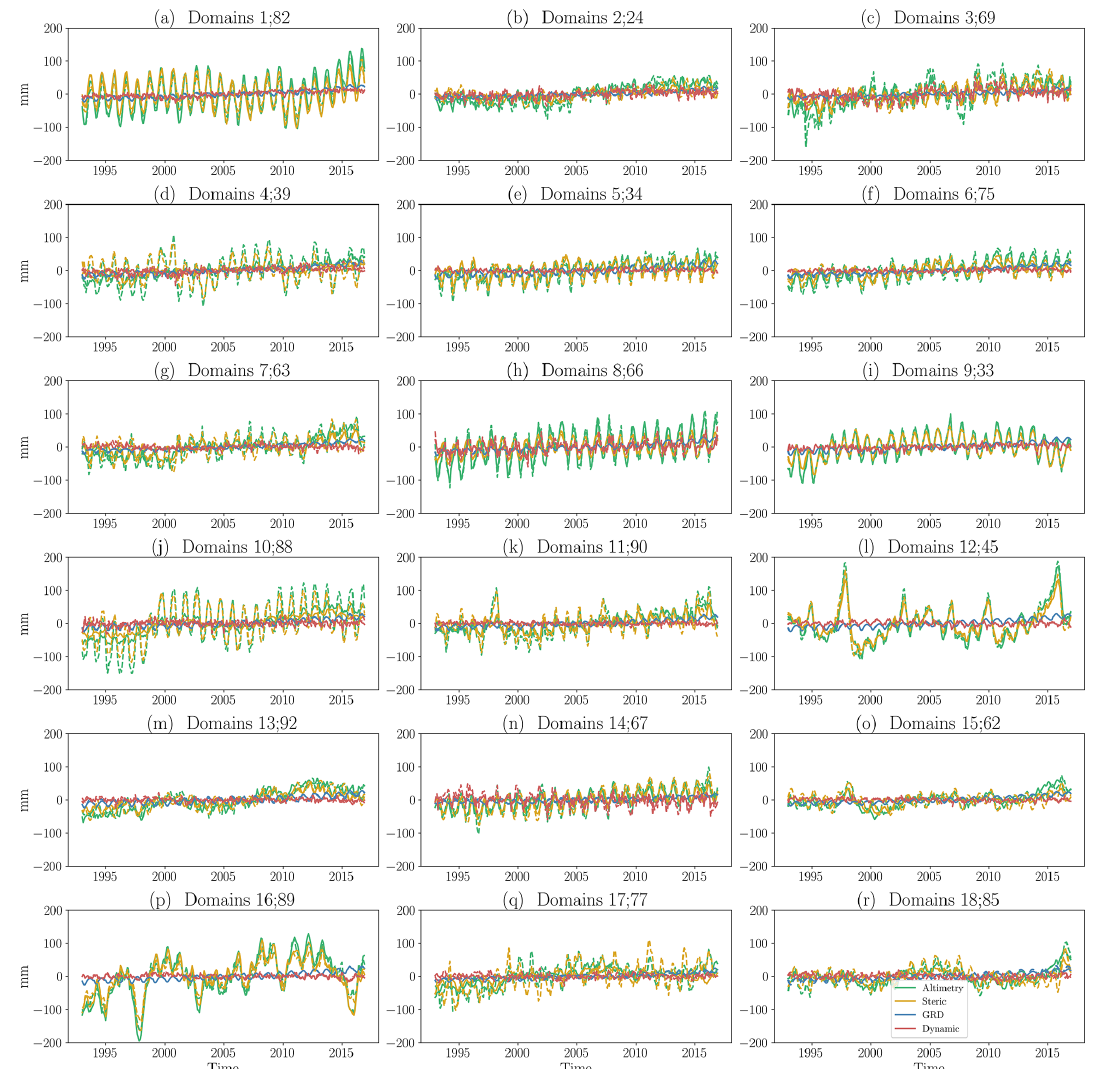
Figure A5. Extension of Fig. 4, showing the time series for each of the SOM domains and corresponding δ -MAPS domains.